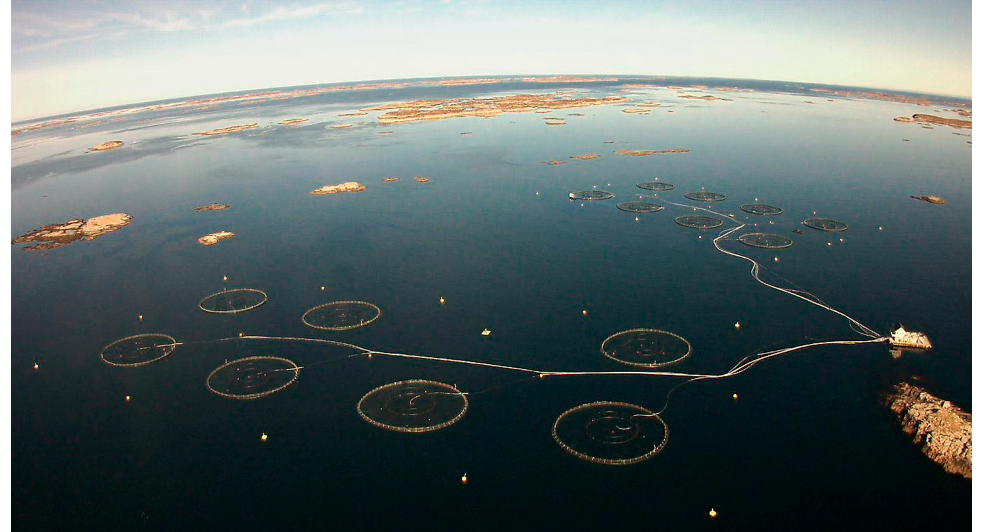
Figure 2. SINTEF ACE, a full-scale laboratory facility designed to develop and test new aquacul- ture technologies.